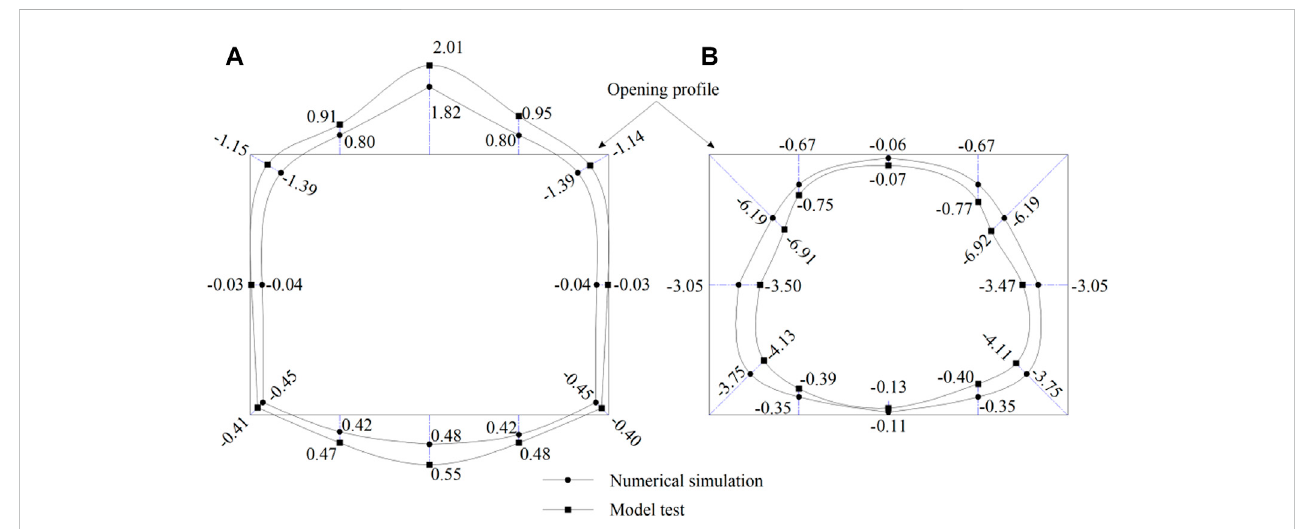
FIGURE 14 Envelope diagrams of the principal stresses around the side wall opening (MPa): (A) First principal stress and (B) Third principal